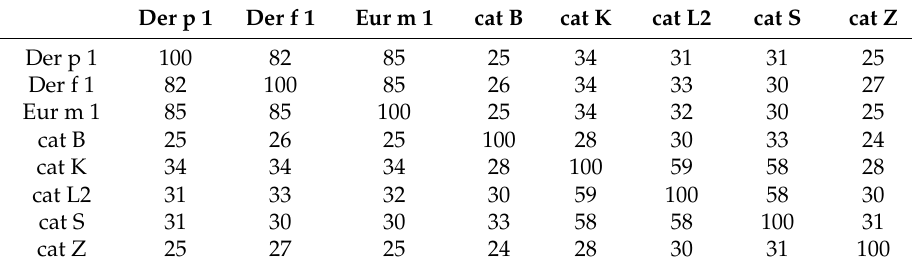
Figure 1. Structure of Der p 1 (Protein Data Bank (PDB): 2AS8; Der p 1.0105 isoform) with positions of catalytic residues shown. For clarity, a surface has been rendered over part of the substrate binding groove. Table 1. Similarity matrix showing percentage identity between the mature protease forms of the house dust mite (HDM) group 1 allergens from Dermatophagoides and Euroglyphus species and cathepsin (cat) family members.